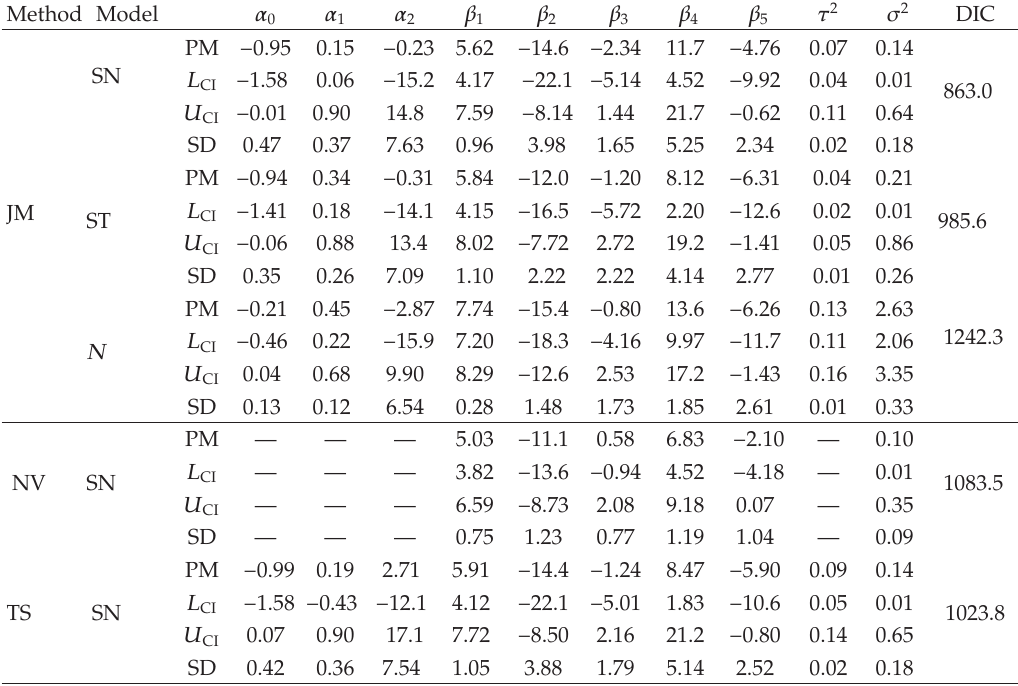
Table 1: A summary of the estimated posterior mean (cid:3) PM (cid:4) of population (cid:3) fixed-e ff ects (cid:4) and scale parame- ters, the corresponding standard deviation (cid:3) SD (cid:4) and lower limit (cid:3) L CI (cid:4) and upper limit (cid:3) U CI (cid:4) of 95% equal- tail credible interval (cid:3) CI (cid:4) as well as DIC values based on the joint modeling (cid:3) JM (cid:4) , the naive (cid:3) NV (cid:4) , and the two-step (cid:3) TS (cid:4)